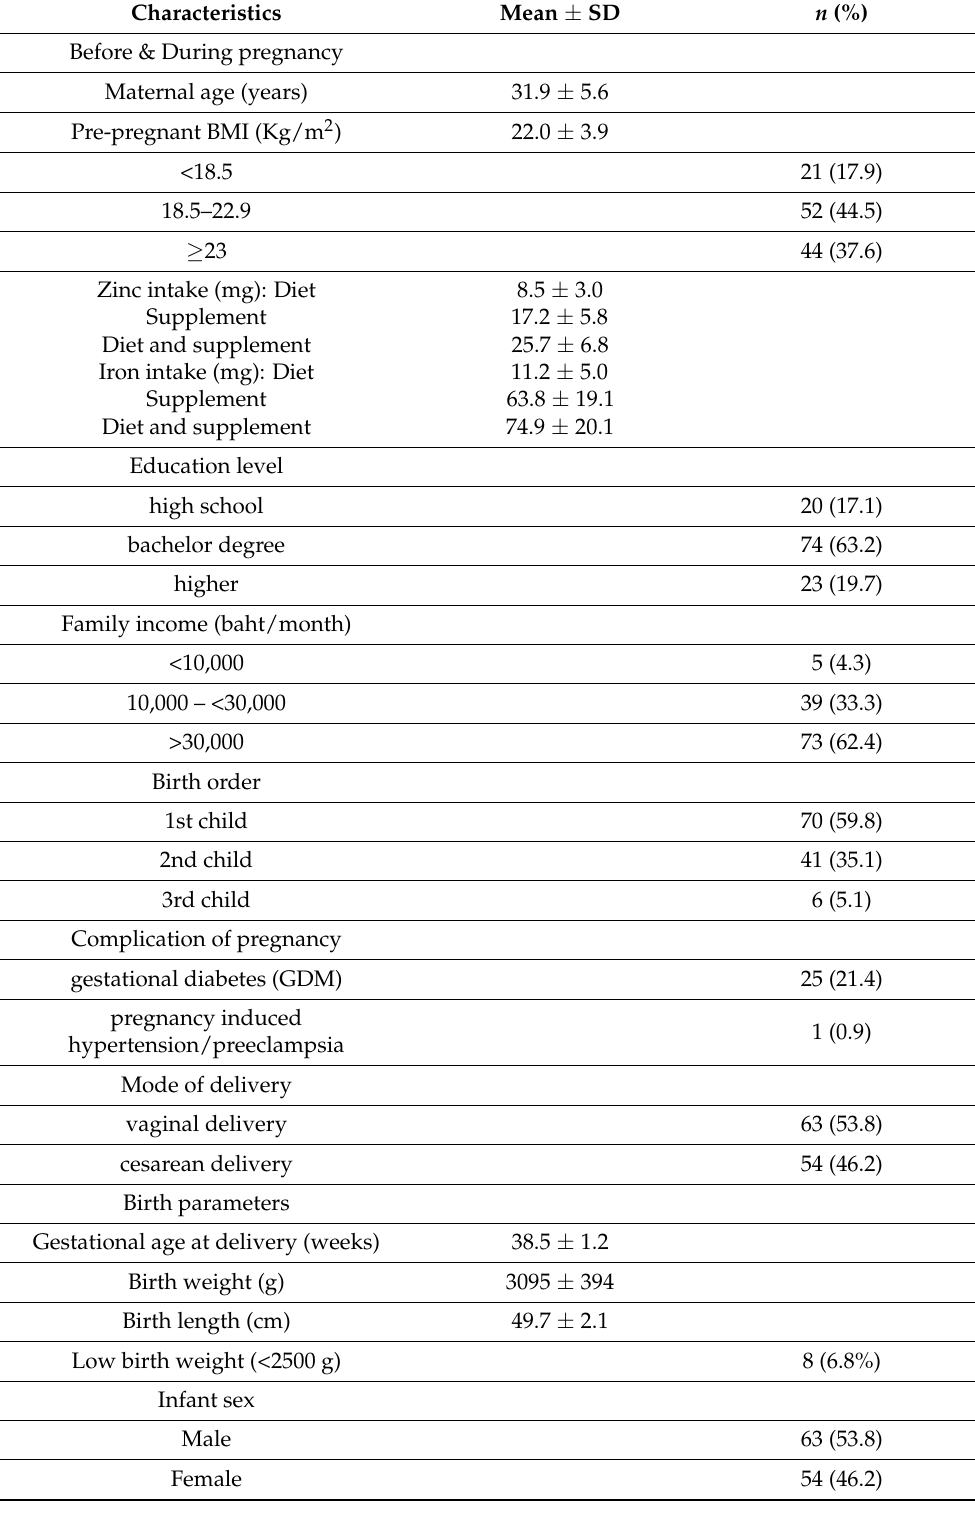
Table 1. Characteristics of study participants ( n = 117)